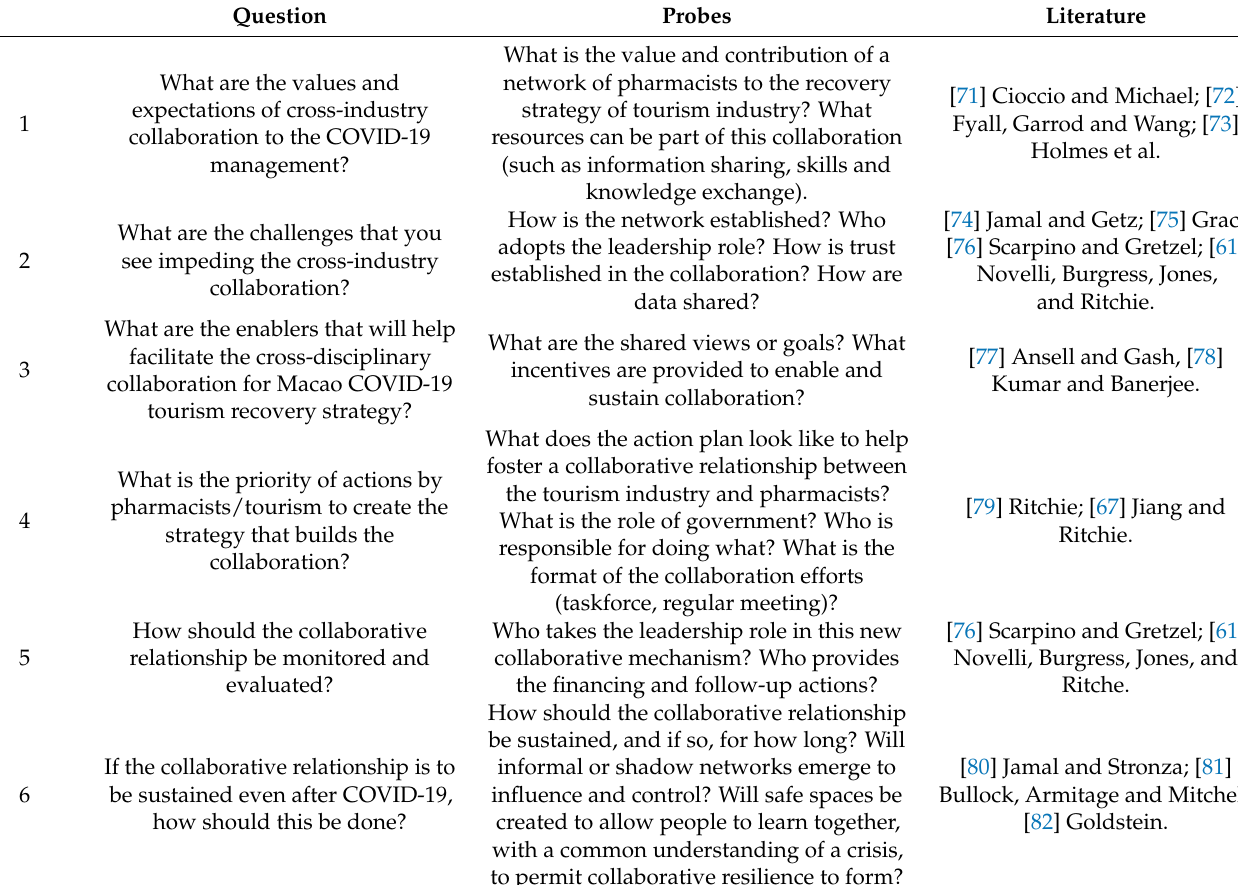
Table 1. Pharmacy and tourism industry interview